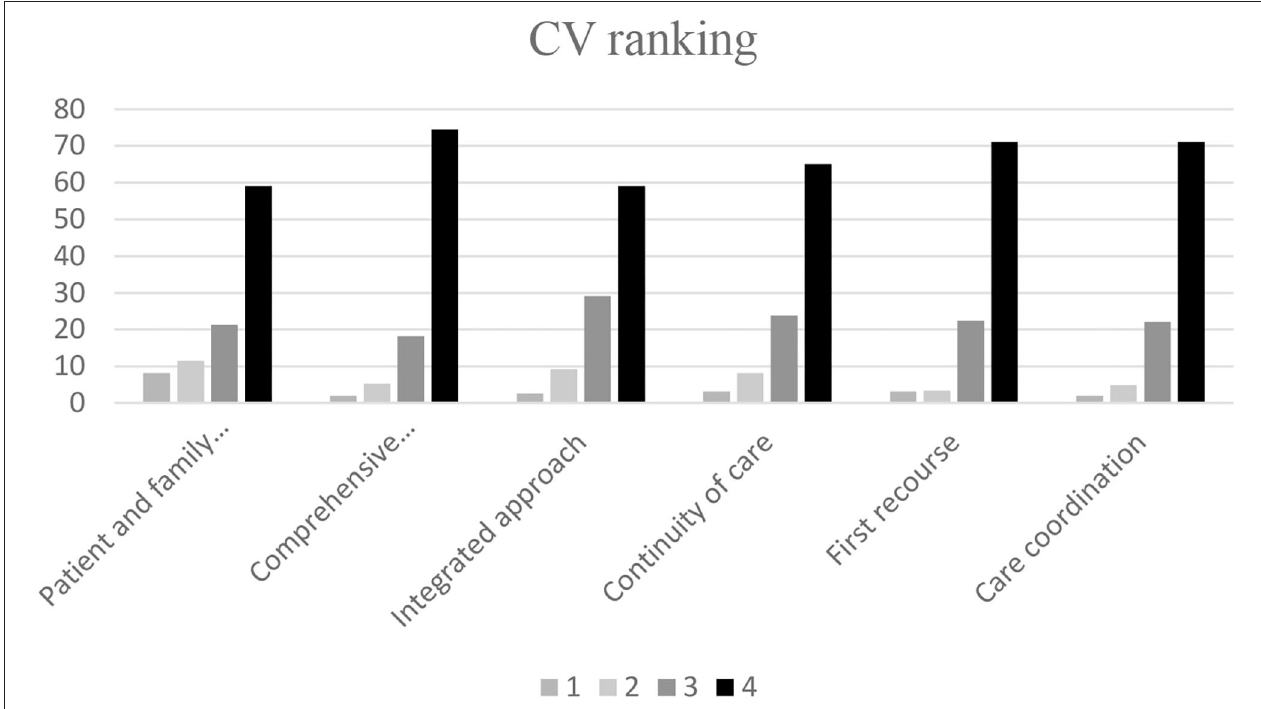
FIGURE 2 | The CV ranking.